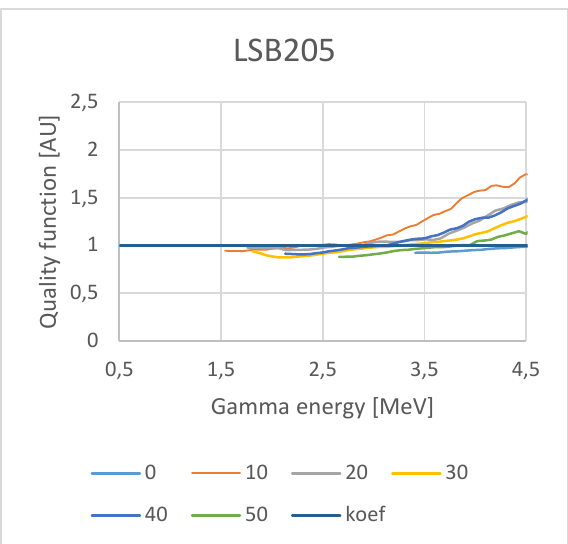
Fig. 2. FOM temperature dependencies of